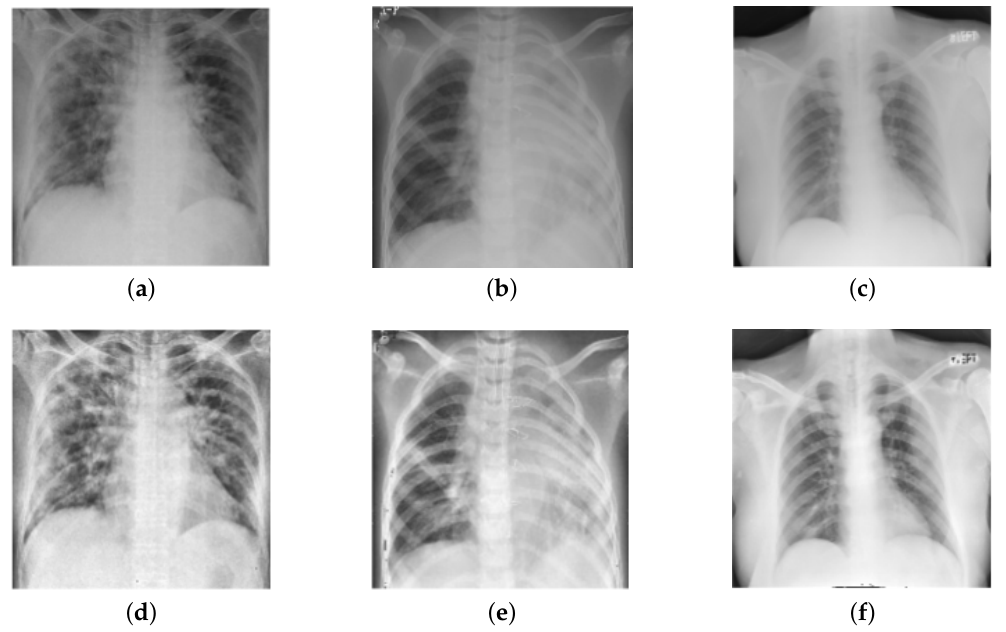
Figure 3. Results of image enhancement (BI and CLAHE): ( a – c ) indicate original images, ( d – f ) indicate enhanced